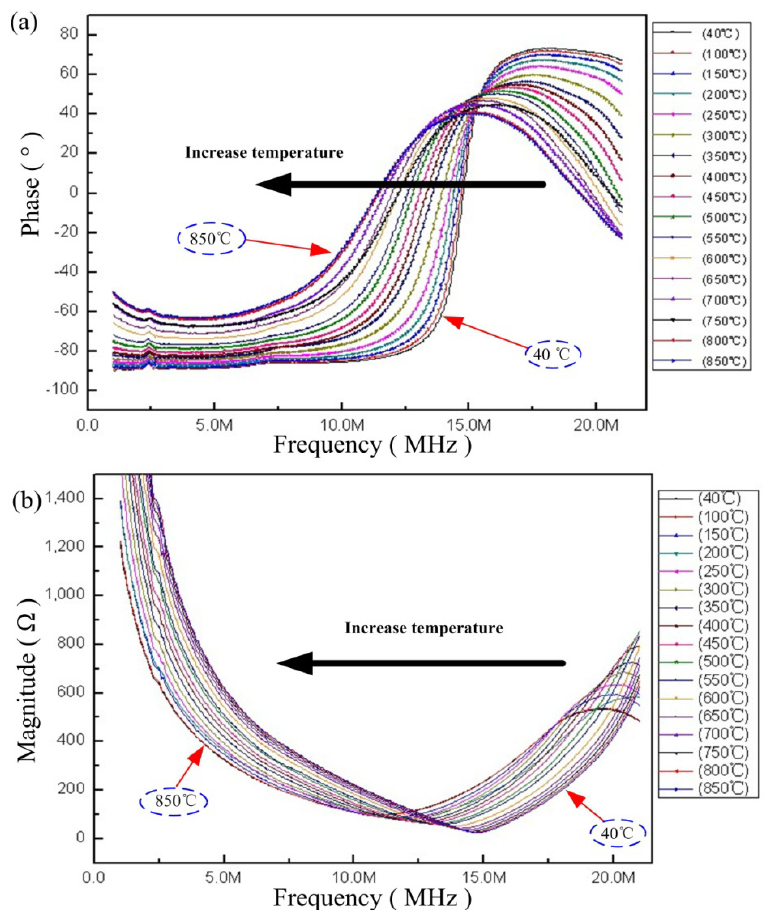
Figure 7. Measured impedance phase ( a ) and impedance magnitude ( b ) versus sensor frequency from 40 °C to 600